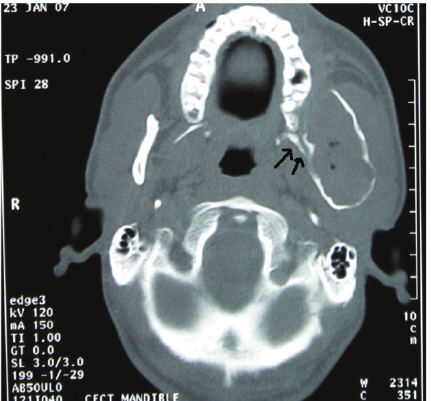
Figure 4: Transverse section of CT showing deflection of the left lateral pterygoid plate medially also with the left maxillary alveolar